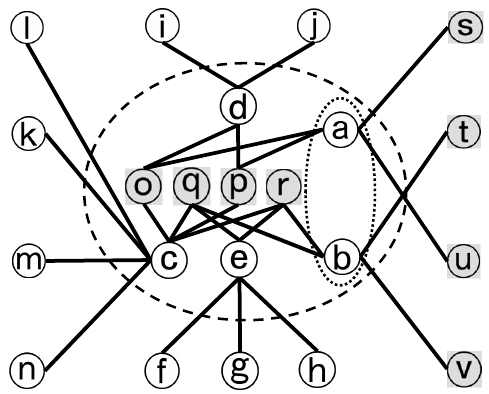
Figure 11. Dual network D N of road network N.